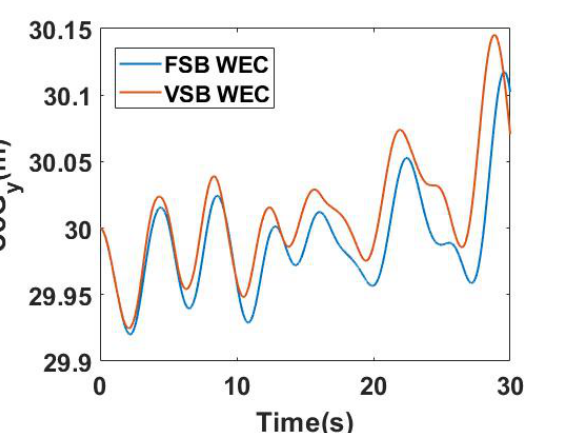
Figure 21. y-directional motion of center of gravity compared between FSB WEC and VSB WEC.